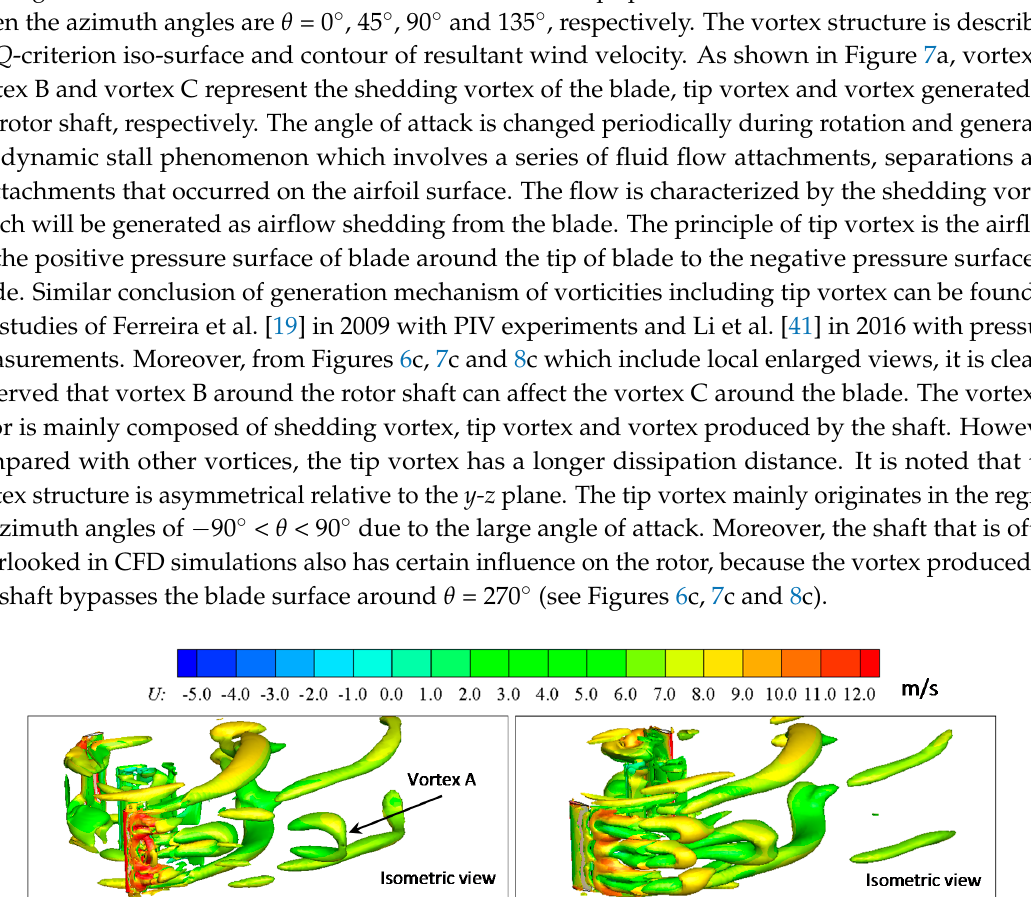
Figure 5. Fluctuations of mean wind velocities for different cross-sections of l = 0, 0.25, 0.50 and 0.75 are compared in cross-section of l = 0 at TSR = 2.19 by CFD simulations and wind tunnel experiments.